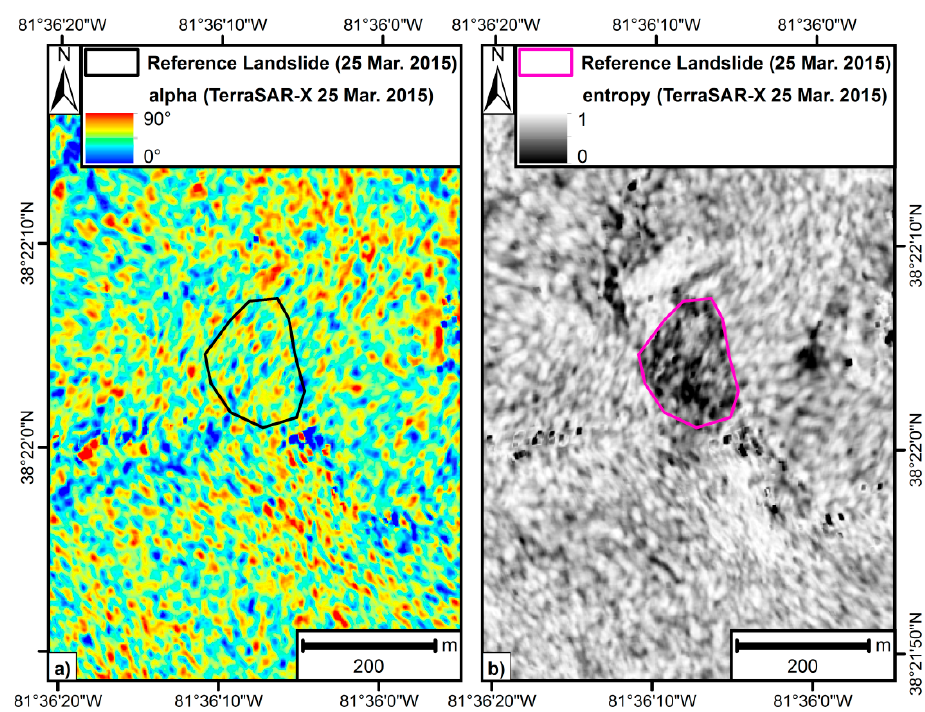
Figure 3. Yeager Airport: ( a ) α angle and ( b ) polarimetric entropy H computed from the post-event dual-pol TerraSAR-X (acquired on 25 March 2015). As described above, the landslide is well recognizable in the H image but not in the α image. The black/pink polygon marks the reference landslide derived by visual interpretation and manual digitization of the TerraSAR-X imagery.